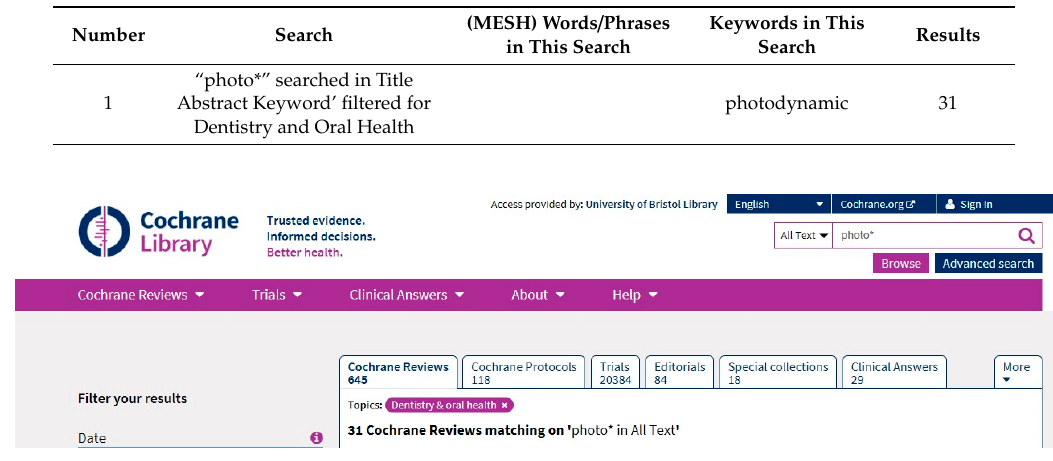
Table A3. Search strategy used for the Cochrane Database.